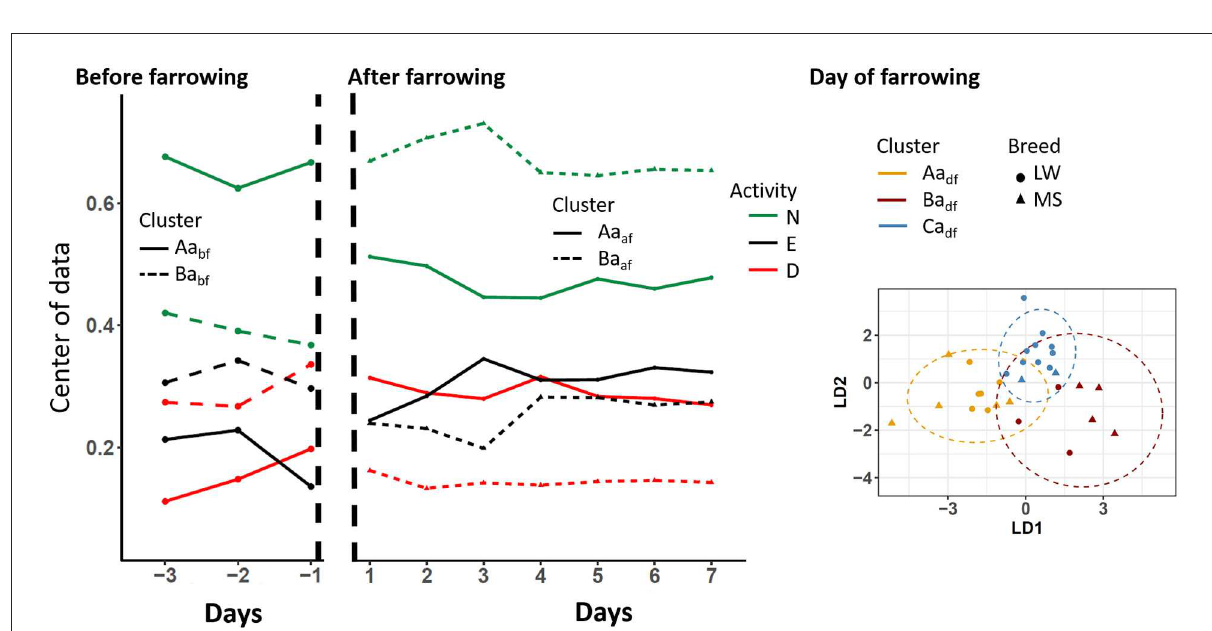
FIGURE4 Longitudinal changes in sow standing activity according to the clusters that were identified before, after, and on the day of farrowing. D, drinking; E, eating; N, something other; LW, Large-White, MS, Meishan. The centers of data are shown in the periods before and after farrowing because the longitudinal analyses were applied. The two first components of the linear discriminant analysis are shown on the day of farrowing.